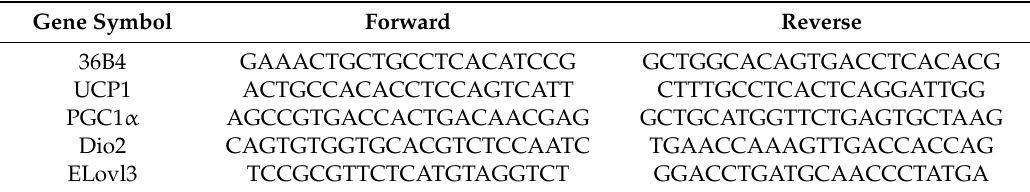
Table 1. The following primers were used in these